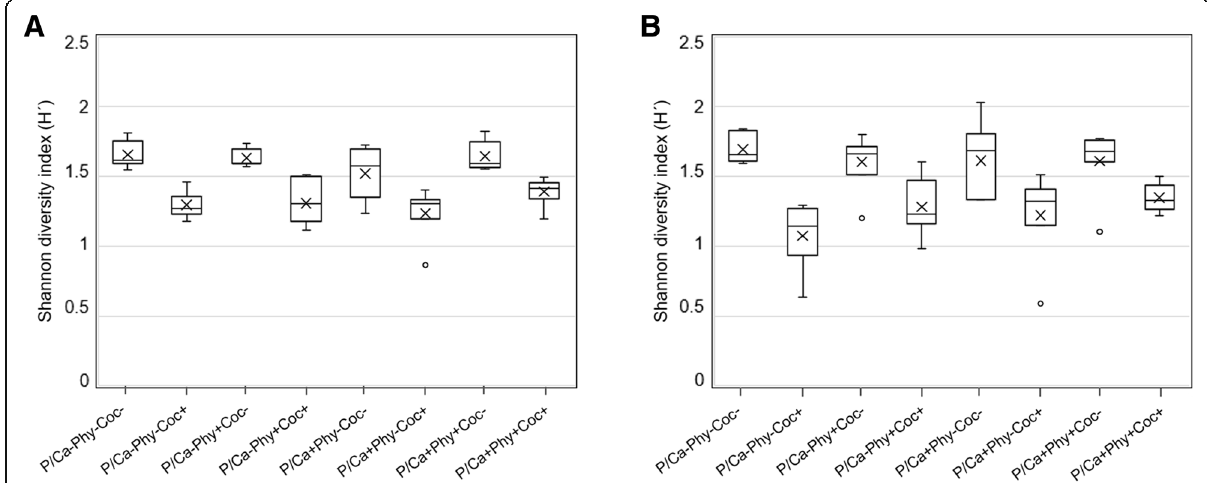
Fig. 2 Diversity measured through the Shannon diversity index. Box plots correspond to the crop ( a ) and ileum ( b ) digesta